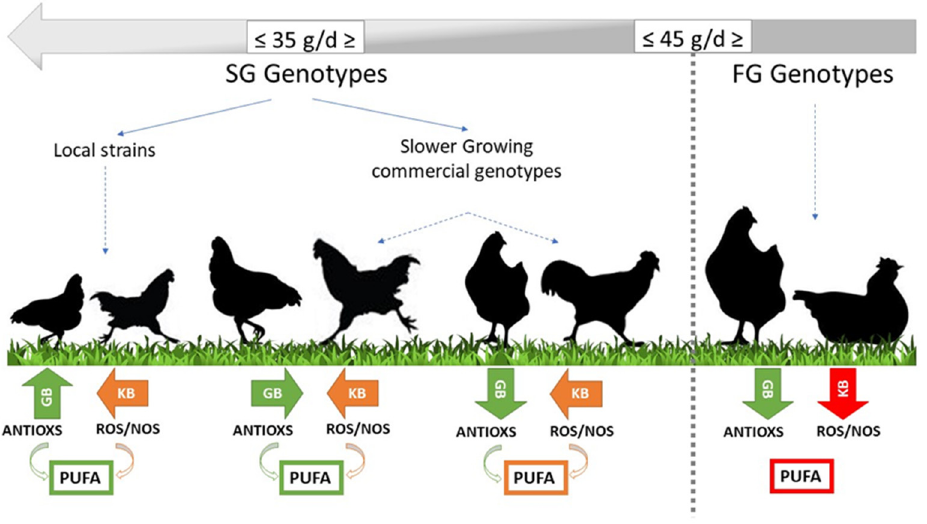
Figure 8. Main oxidative interactions in poultry strains adapted/non-adapted to ERS. GB: grazing behavior, KB: kinetic behavior, ROS: reactive oxygen species, and NOS: reactive nitrogen species PUFA: polyunsaturated fatty acids.